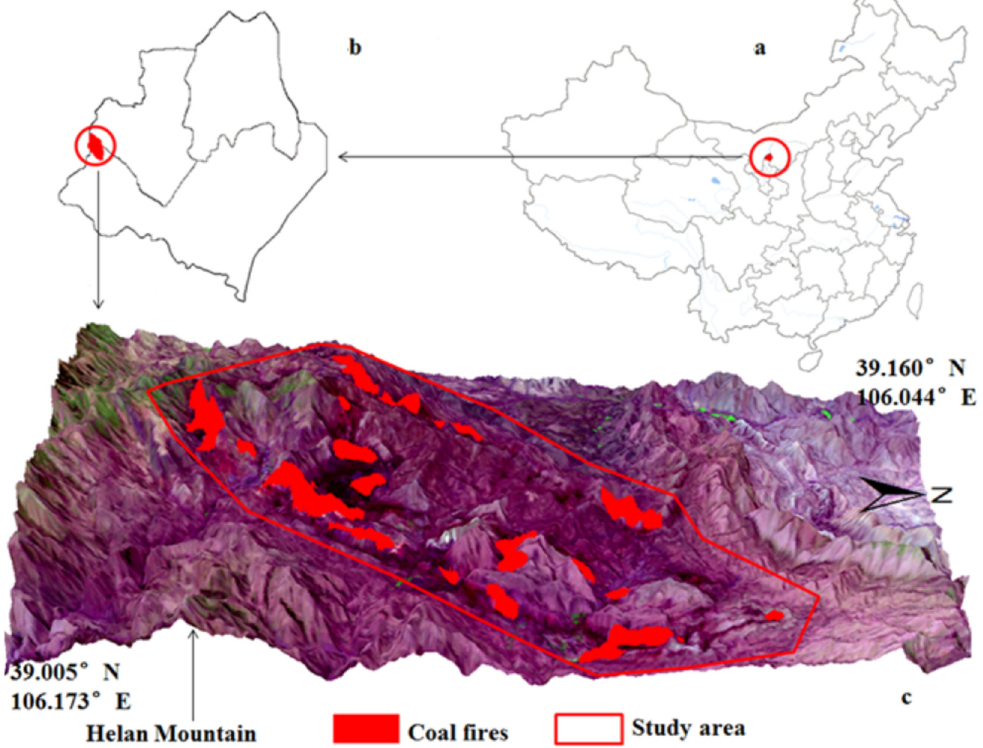
Figure 2. Study area of Rujigou Coal Field: ( a ) shows the location and direction of study area in Northwest China, ( b ) shows the Rujigou Coal Field located in the Rujigou district, in Shizuishan city and ( c ) is a 3-D FCC (False Color Composite) image (generated by coding ETM+7/4/2 in R/G/B) based on Landsat ETM+ data acquired on 12 August 1999, overlaid by coal fire map from local mineral bureau, obtained from a field survey of 2002–2003, Projection: UTM, zone 48 North, WGS